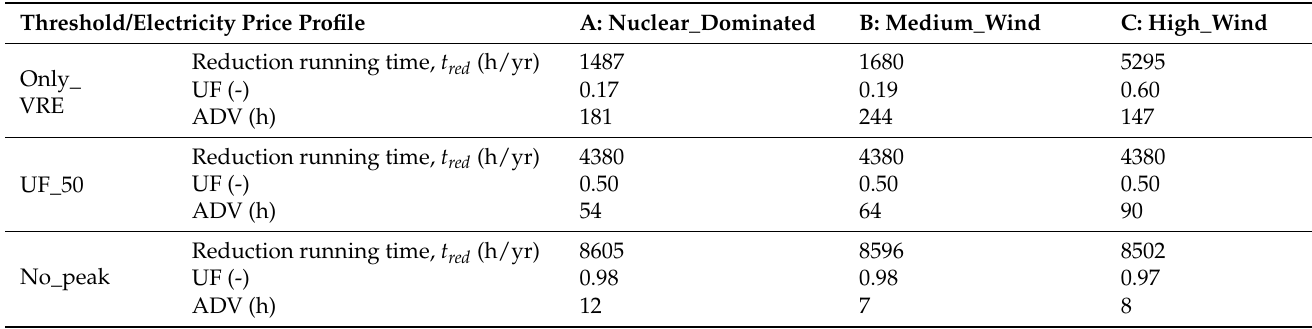
Table 2. Characteristics of the nine scenarios considered in this work. The parameters are calculated according to the characteristics of the electricity price profiles and the criteria formulated for the selection of thresholds. UF, utilization factor; ADV, average duration of